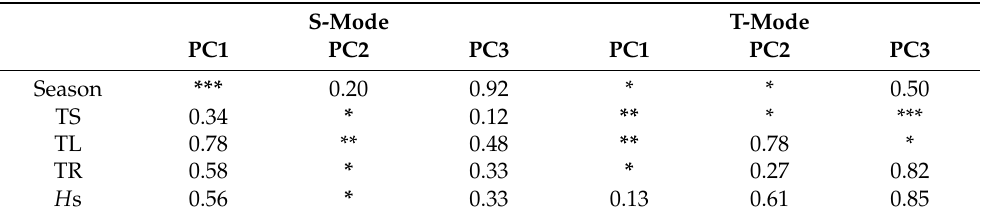
Table 3. p -values (significance code: “***” 0.001; “**” 0.01; “*” 0.05) of statistical analyses between the three first principal components using the S-mode and T-mode orientation and environmental